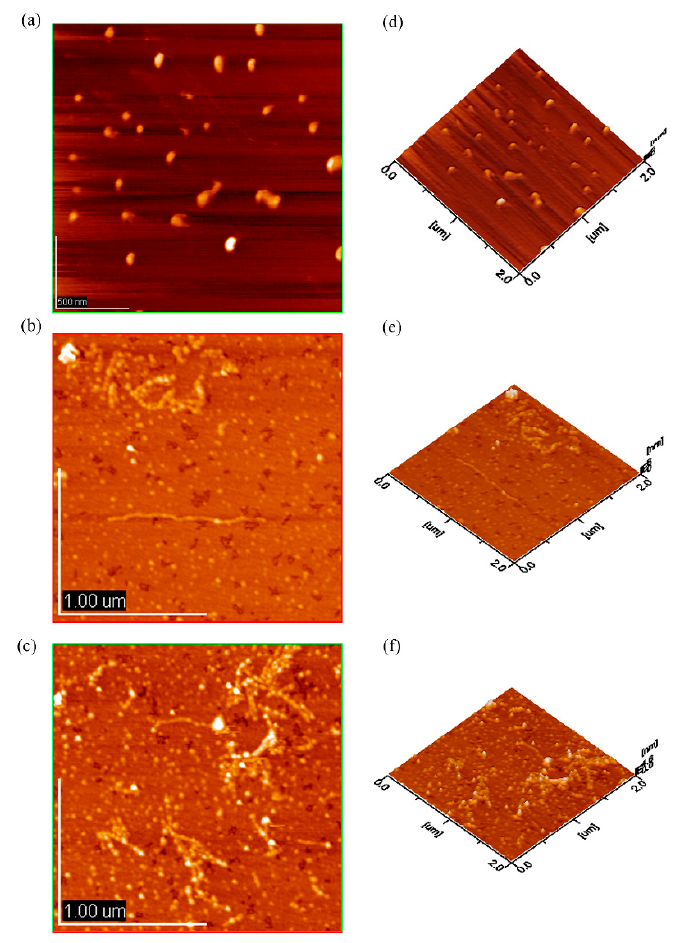
Figure 6. Atomic force microscopy (AFM) 2-D (( a ), ( b ), and ( c )) and 3-D (( d ), ( e ), and ( f )) images of molecular structure of EPS-1a ( a , d ), EPS-2a ( b , e ), and EPS-3a ( c , f ). The concentration was 100 μ g/mL.